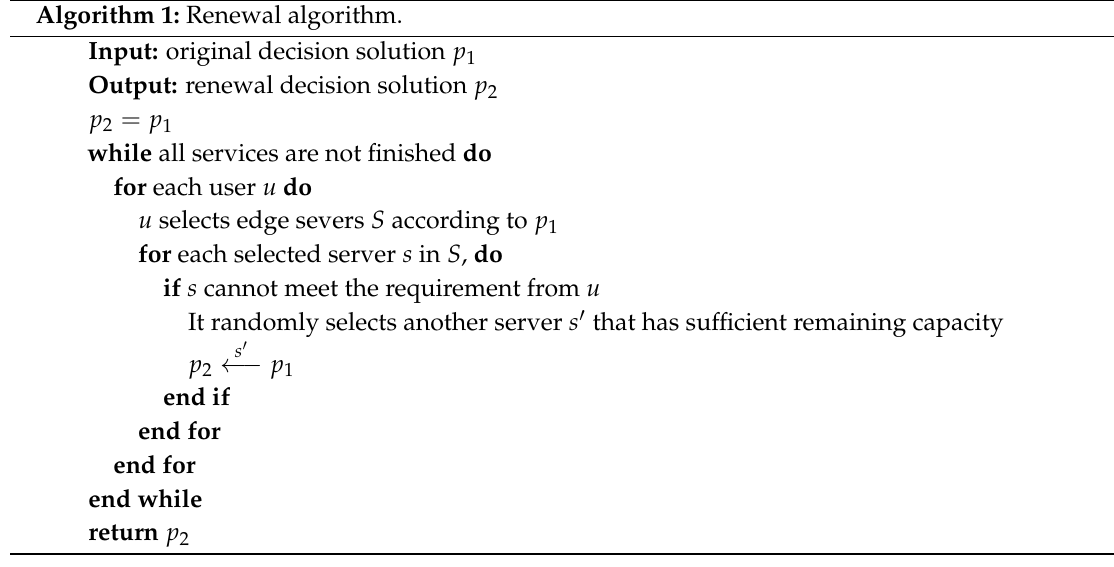
Algorithm 2: MESP